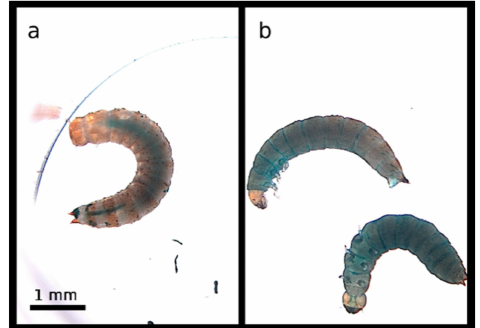
Figure 2. Range of phenotypes exhibited by T. castaneum larvae upon ingestion of the positive control diet. ( a ) Healthy control T. castaneum larva with a well-defined digestive tract filled with blue-dyed agarose. ( b ) Dead larvae showing the Smurf phenotype upon ingestion of the positive control diet. The larvae were 20 days old at the beginning of the experiment and died within one day of